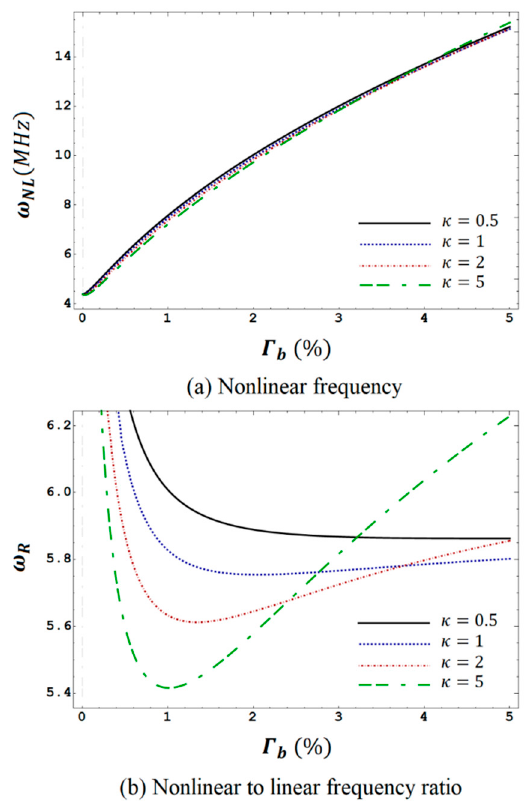
Figure 11. Variation of the first-order nonlinear frequency and nonlinear-to-linear frequency ratio of a GPL-reinforced sandwich beam with respect to an increasing total amount of GPLs in the beam, for di ff erent power-law parameters ( h c / h t = 0.6, N = 10, a / h t = 3, L / h t = 10 ).